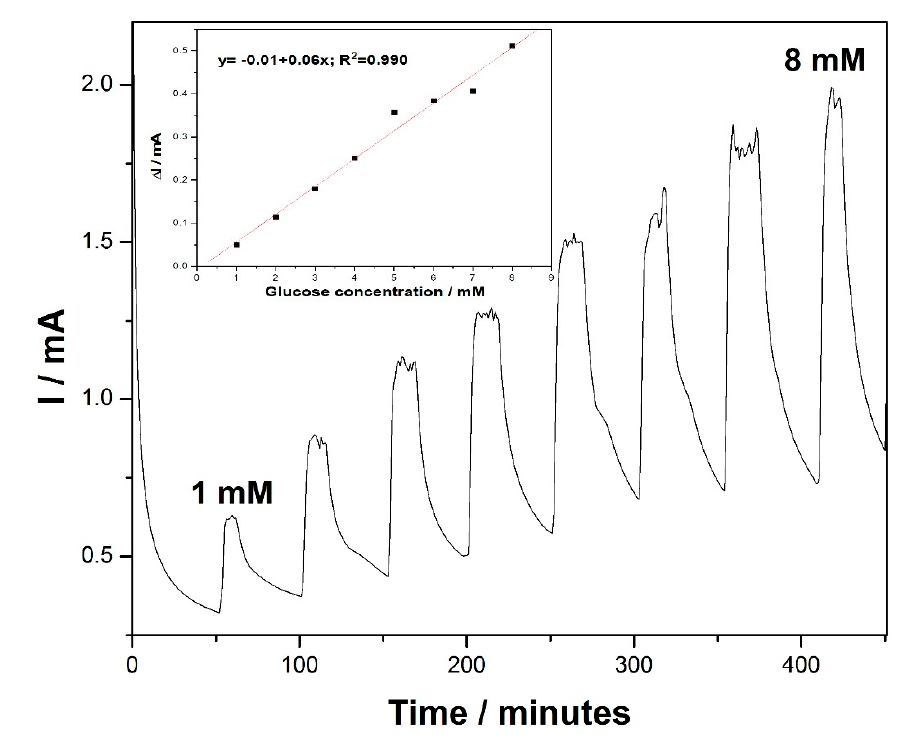
Figure 6. Chronoamperometry (CA) recordings at the MWCNT-CuBTC composite electrode in 0.1 M of NaOH supporting electrolyte and in the presence of various glucose concentrations from 1 mM to 6 mM under stirring conditions. The inset shows the calibration plots of the current recorded at +0.6 V/SCE versus the glucose concentration.